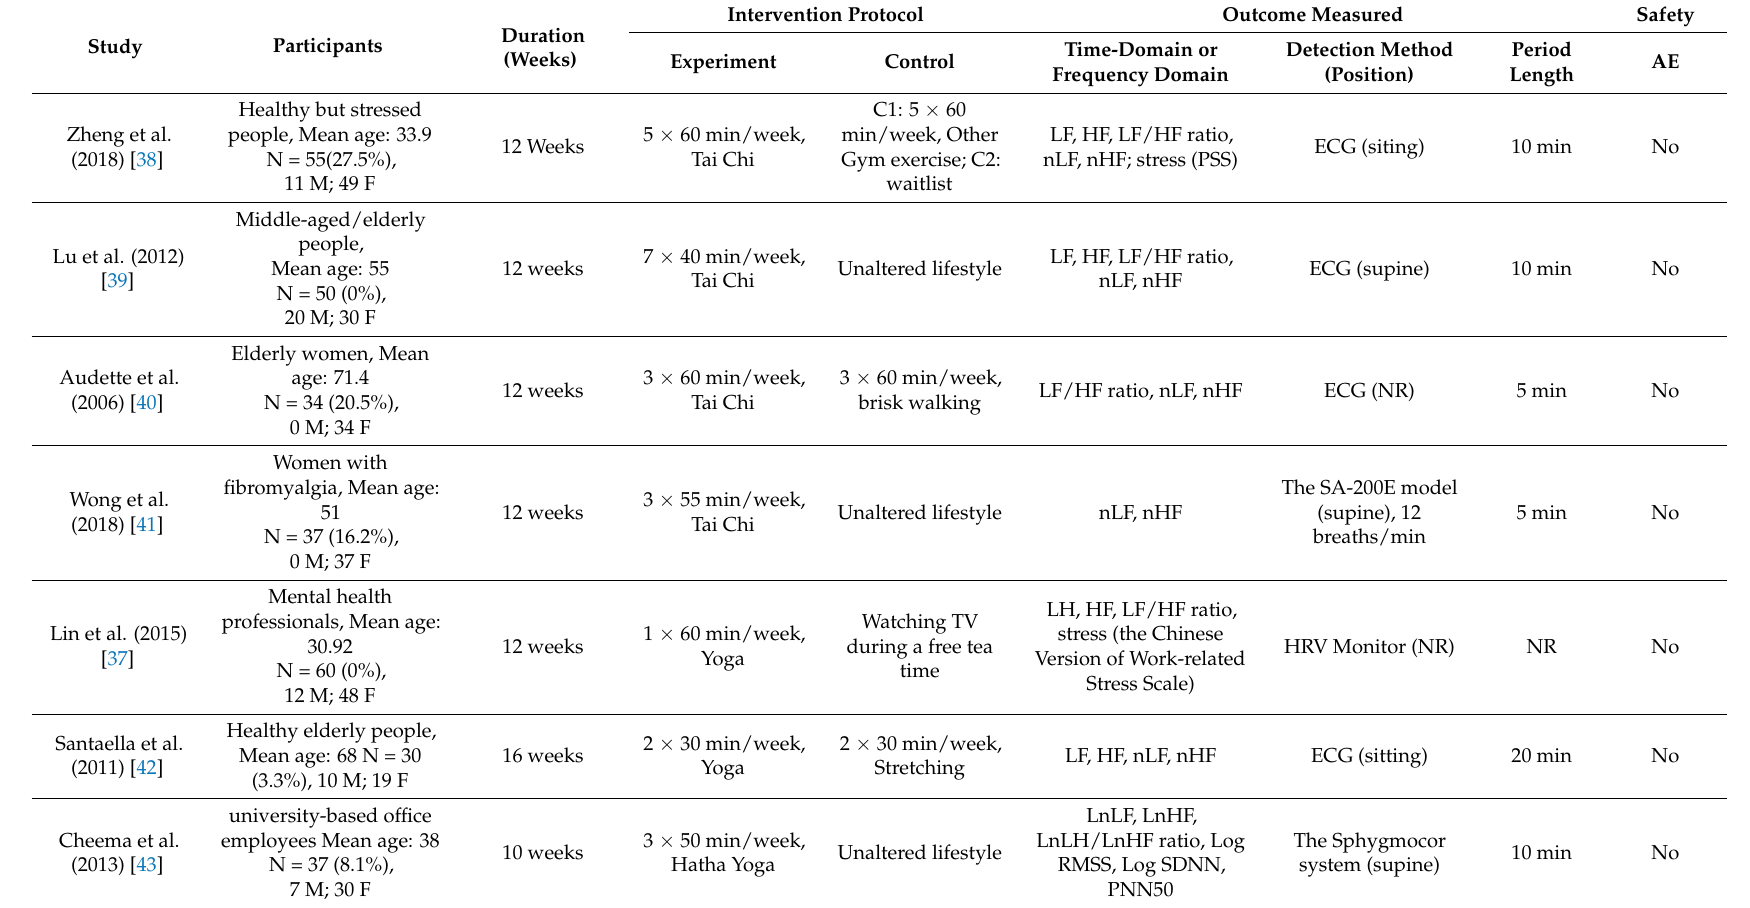
Table 1. Features of randomized controlled